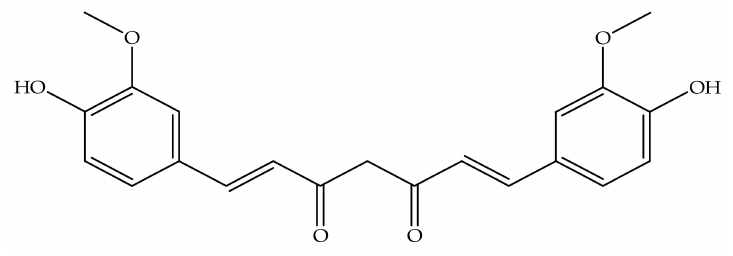
Figure 1. Chemical structure of CUR MW = 368.38 g/mol